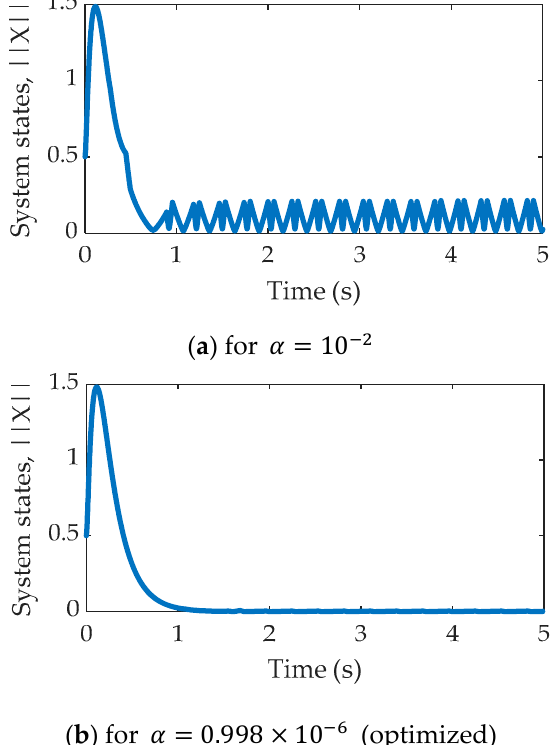
Figure 3. Inverted pendulum system states, ‖(cid:1850)‖ .